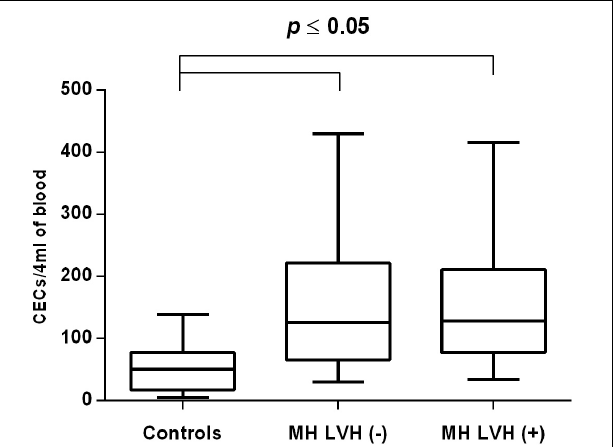
FIGURE 1 | CECs number in patients with and without LVH belonging to MH group. Box and whisker plots show median (central line), upper and lower quartiles (box) and range excluding outliers (whiskers). Data were analyzed using Kruskal–Wallis test followed by the Dunn’s multiple comparison test. P ≤ 0.05 was considered statistically